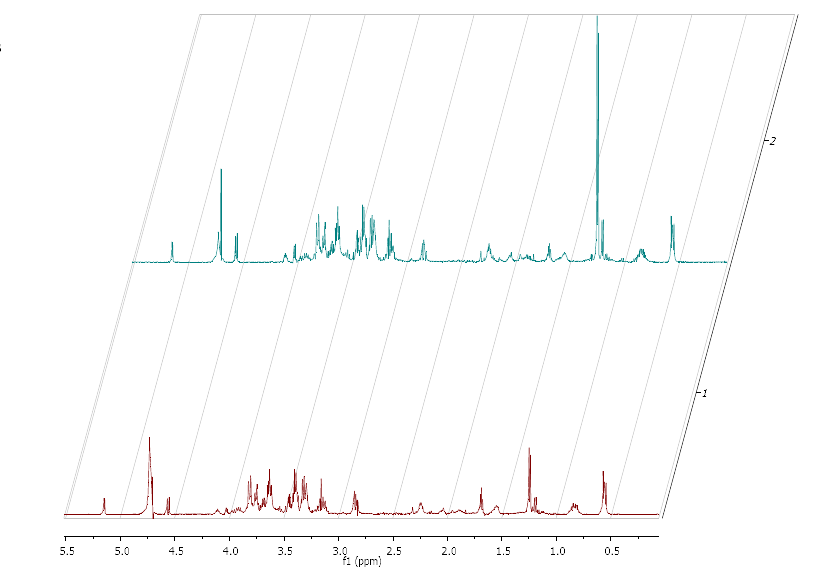
Figure 7 . A part of 1 H NMR spectrum of L929 fibroblasts samples after 2 h ( A ) and after 24 h ( B ). The 1 H NMR spectrum of staphylococcal biofilm cultured alone revealed also signifi- cant shifts in footprint metabolites after 2 and 12 h of culturing (Figure 8).